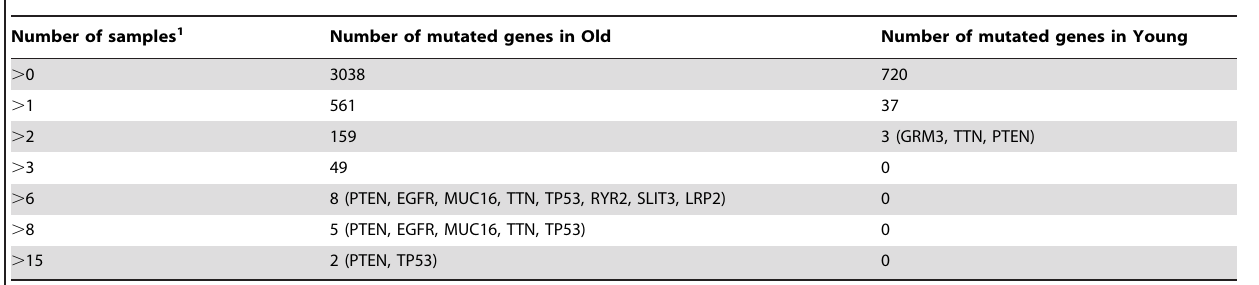
Table 3. Number of mutated genes in old and young GNEG